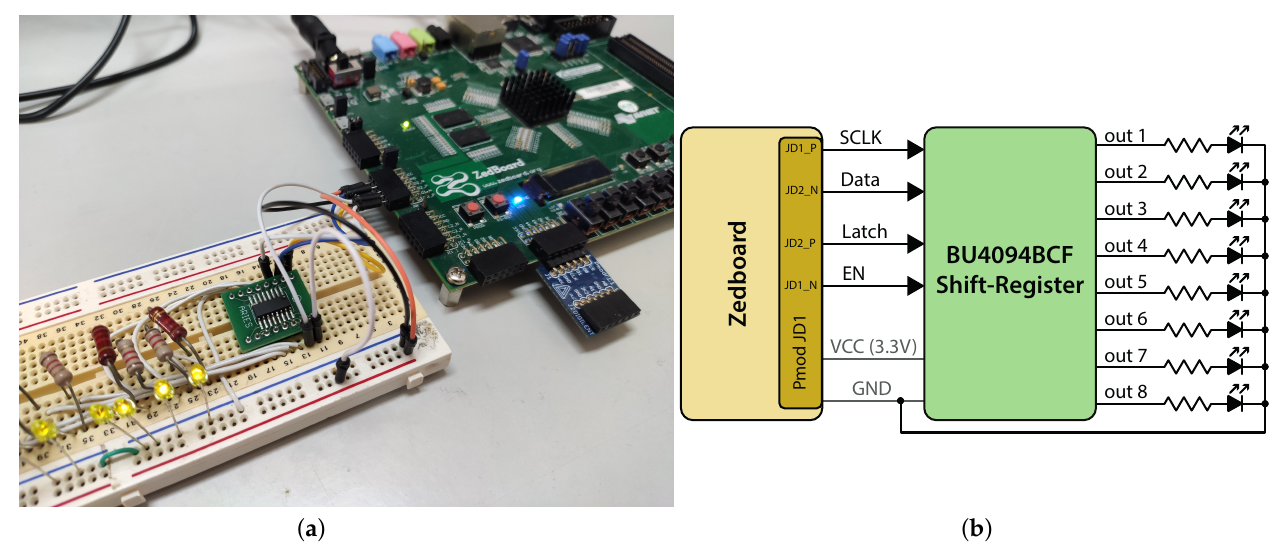
Figure 22. Shift-register installation for testing with the Zedboard and demo model. ( a ) Experimental assembly. ( b ) Schematic